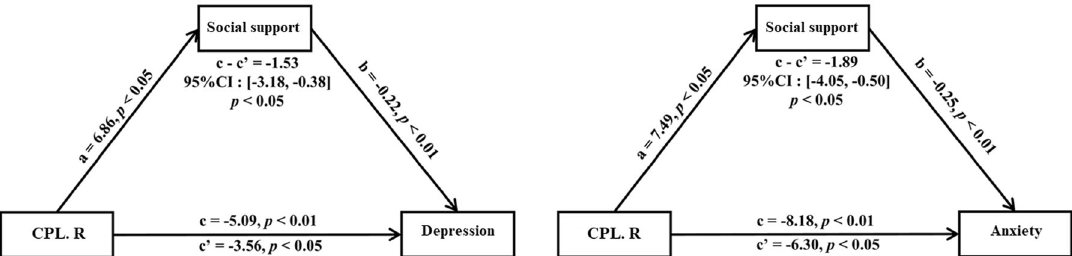
Fig. 3 Mediation analysis revealed that FCS of right cerebellem posterior lobe (CPL) affects postpartum depression and anxiety through social support. In particular, social support as measured by the PSQ questionnaire mediates the effect of right CPL on Edinburgh Postnatal Depression Scale (EPDS) and Beck ’ s Anxiety Inventory (BAI)